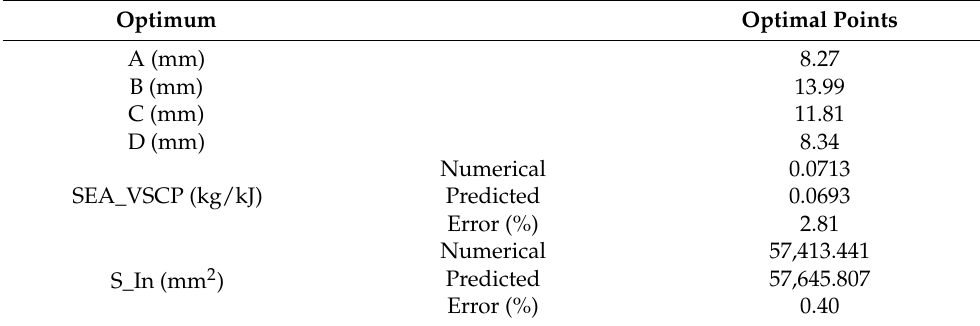
Table 8. Confirmation of optimal solution.